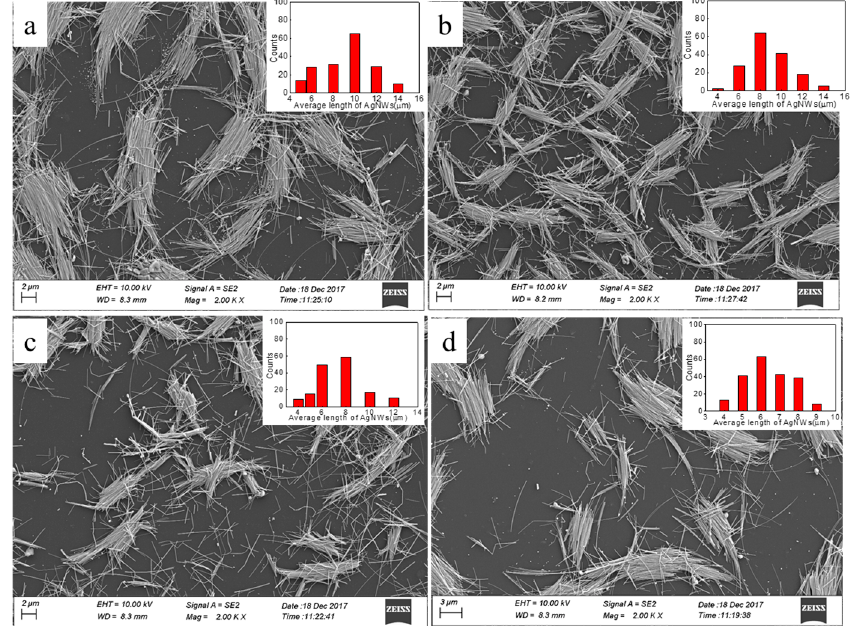
Figure 2. SEM images of AgNWs treated with ultrasonic power 120 W and different ultrasonic time. Ultrasonic time: ( a ) 1 h, ( b ) 2 h, ( c ) 4 h, ( d ) 5 h. The inserted images are the length distribution.